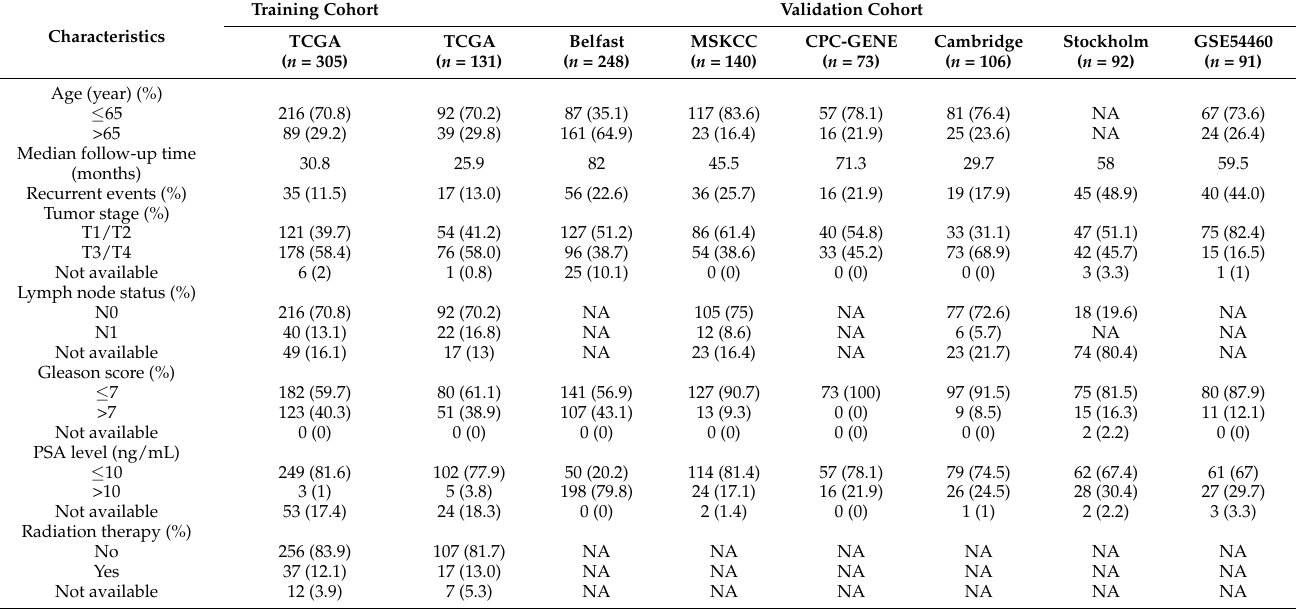
Table 1. Characteristics of patient cohorts used for the analysis of recurrence-free survival (RFS).